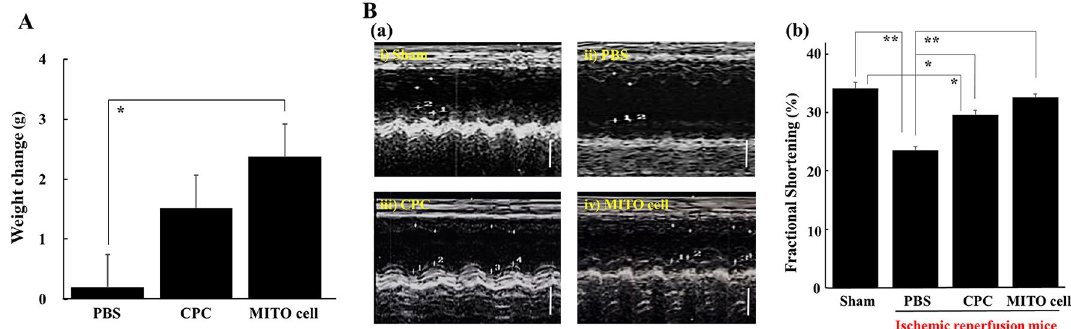
Figure 5. Evaluation of therapeutic effect after cell transplantation. ( A ) Body weight of mice after ischemic perfusion. This figure shows the change in body weight at 30 days after transplantation of each group (PBS treated group (n = 7), CPC group (n = 6), MITO-cell group (n = 6)) in an ischemia–reperfusion mouse model. Data are represented as the mean with S.D. (n = 6–7). *Significant differences were calculated by one-way ANOVA, followed by SNK test (p < 0.05). ( B ) Evaluation of cardiac function of ischemic myocardium. ( a ) Echocardiographic image in 30 days after cell transplantation in ischemia reperfusion model mice. (i) Sham operation mice, (ii) PBS treated, (iii) CPC transplanted and (iv) MITO cell transplanted ischemic reperfusion model mice. Scale bars 2 mm. ( b ) Comparison of fraction shortening among these groups. Fraction shortening (%) was estimated by two-dimension (see “Methods” section for the detail). Sham; Sham operation mice (n = 11), PBS; PBS treated (n = 5), CPC CPC transplanted (n = 6) and MITO cell MITO cell transplanted (n = 6) ischemic reperfusion model mice group. Data are represented as the mean ± S.D. Significant differences (*p < 0.05, **p < 0.01) were calculated by one-way ANOVA, followed by SNK test.